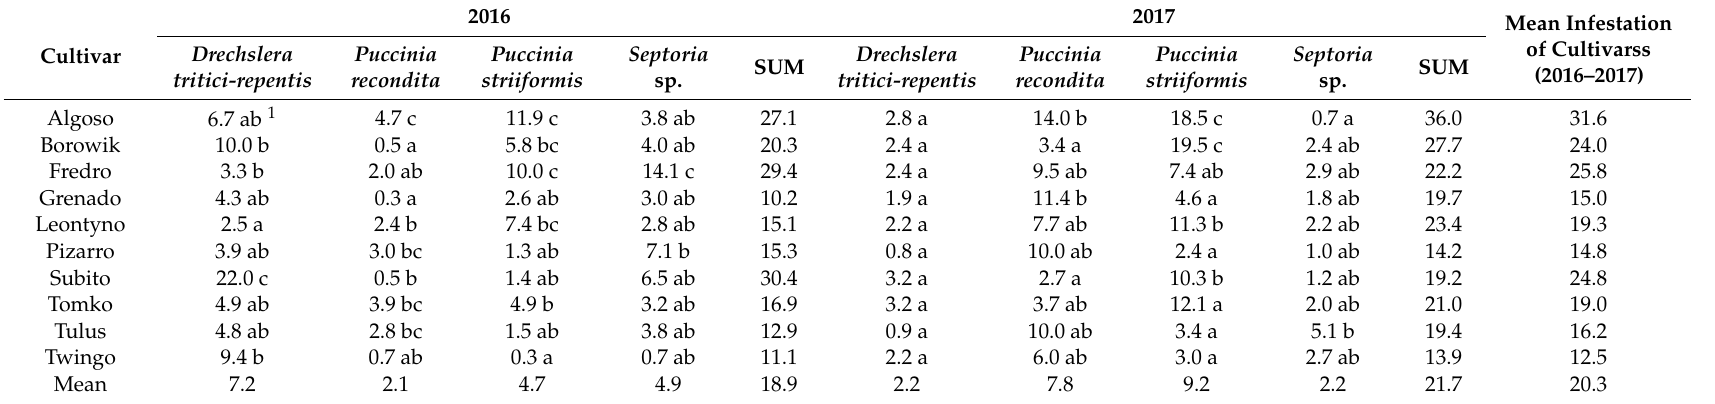
Table 7. Infestation of triticale cultivars by fungal pathogens (% of leaf blade infected, 3 upper leaves L1-L3 in total).